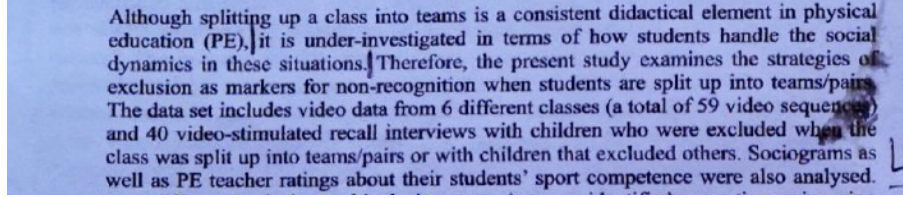
Figure 2. Annotating for Swale’s moves (Reprinted from Grimminger 2014, p. 155).